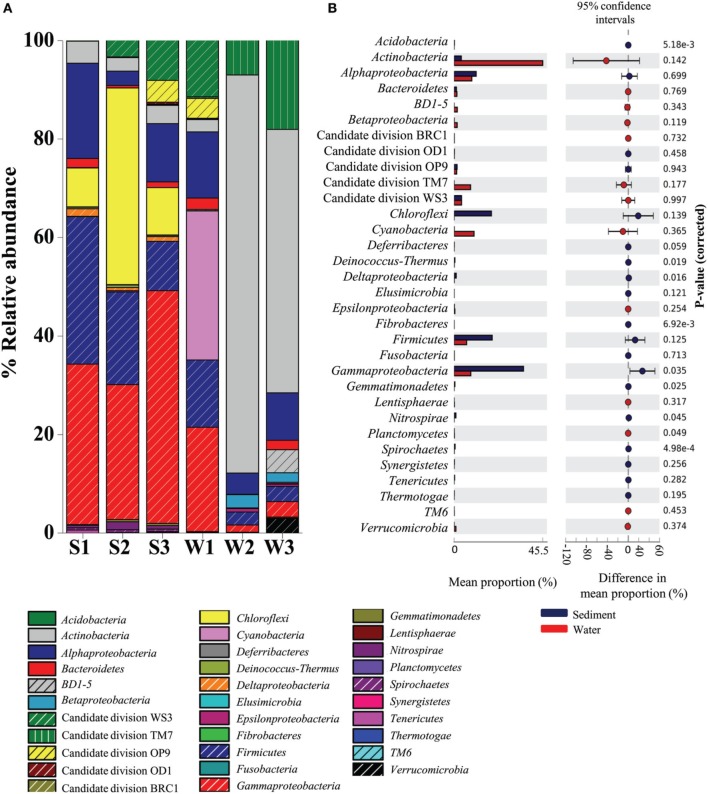
Distribution of major phylogenetic groups of bacteria in (A) across the sediment and water samples, and (B) overall distribution between sediment and water samples of the Lonar Lake. Bacterial abundance in the sediment sample has a positive difference between proportions (blue circles), whereas bacterial abundance in the water sample has a negative difference between proportions (red circles). Bars on the left represent the proportion of each bacterial phyla abundance in the samples. Bacterial abundance difference with a p-value of >0.05 were considered to be significant.